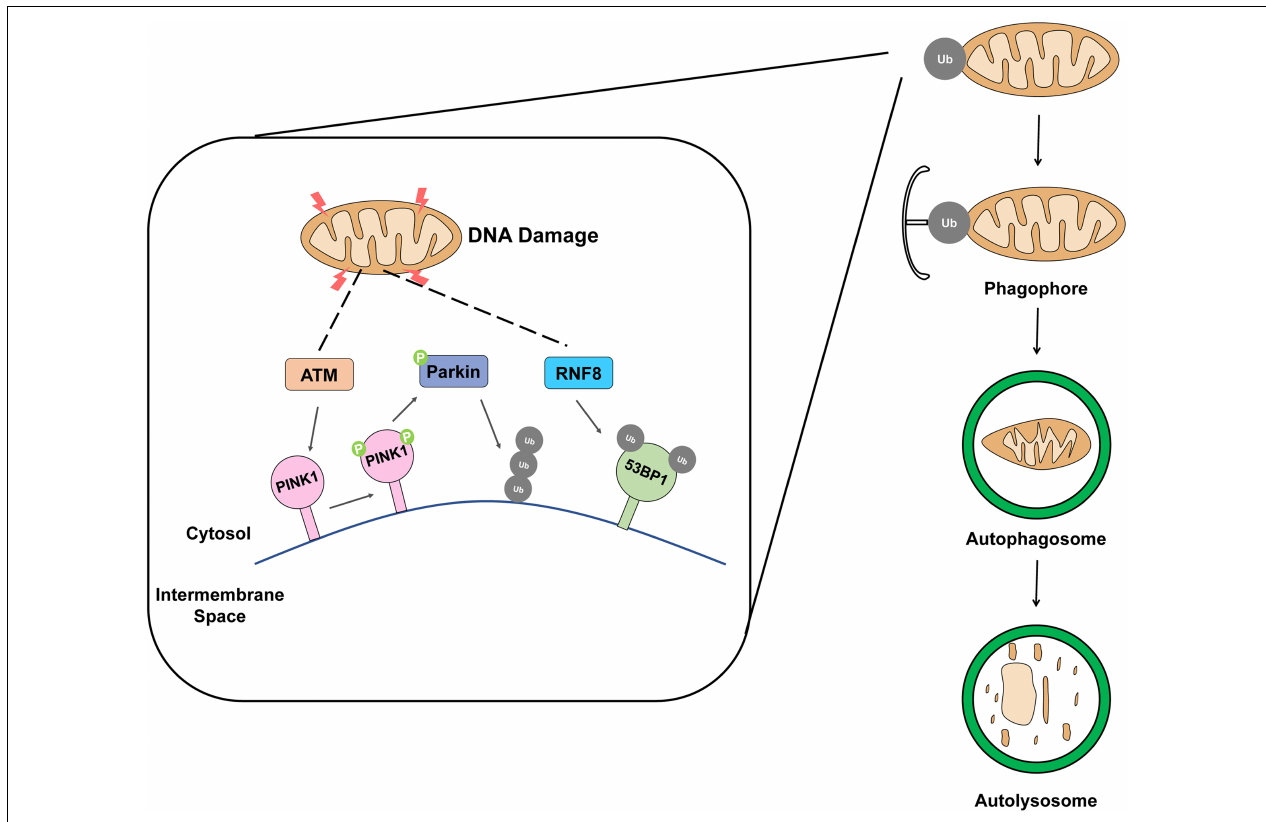
FIGURE 1 | Schematic representation of removing damaged mitochondria by mitophagy. The accumulation of damaged mitochondria is removed by mitophagy when mitochondria are exposed to DNA damage factors such as ionizing radiation, ROS, and